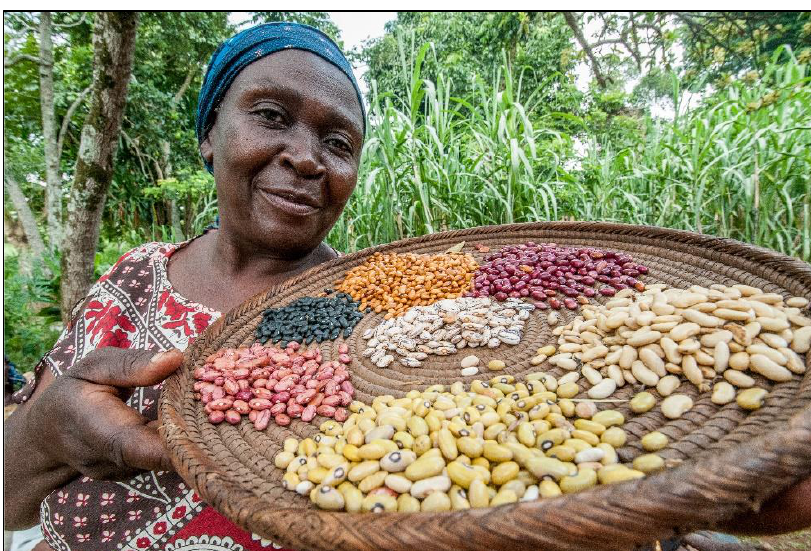
Figure 1. Diverse Common Bean Grown by Smallholder Women Farmers in Uganda,